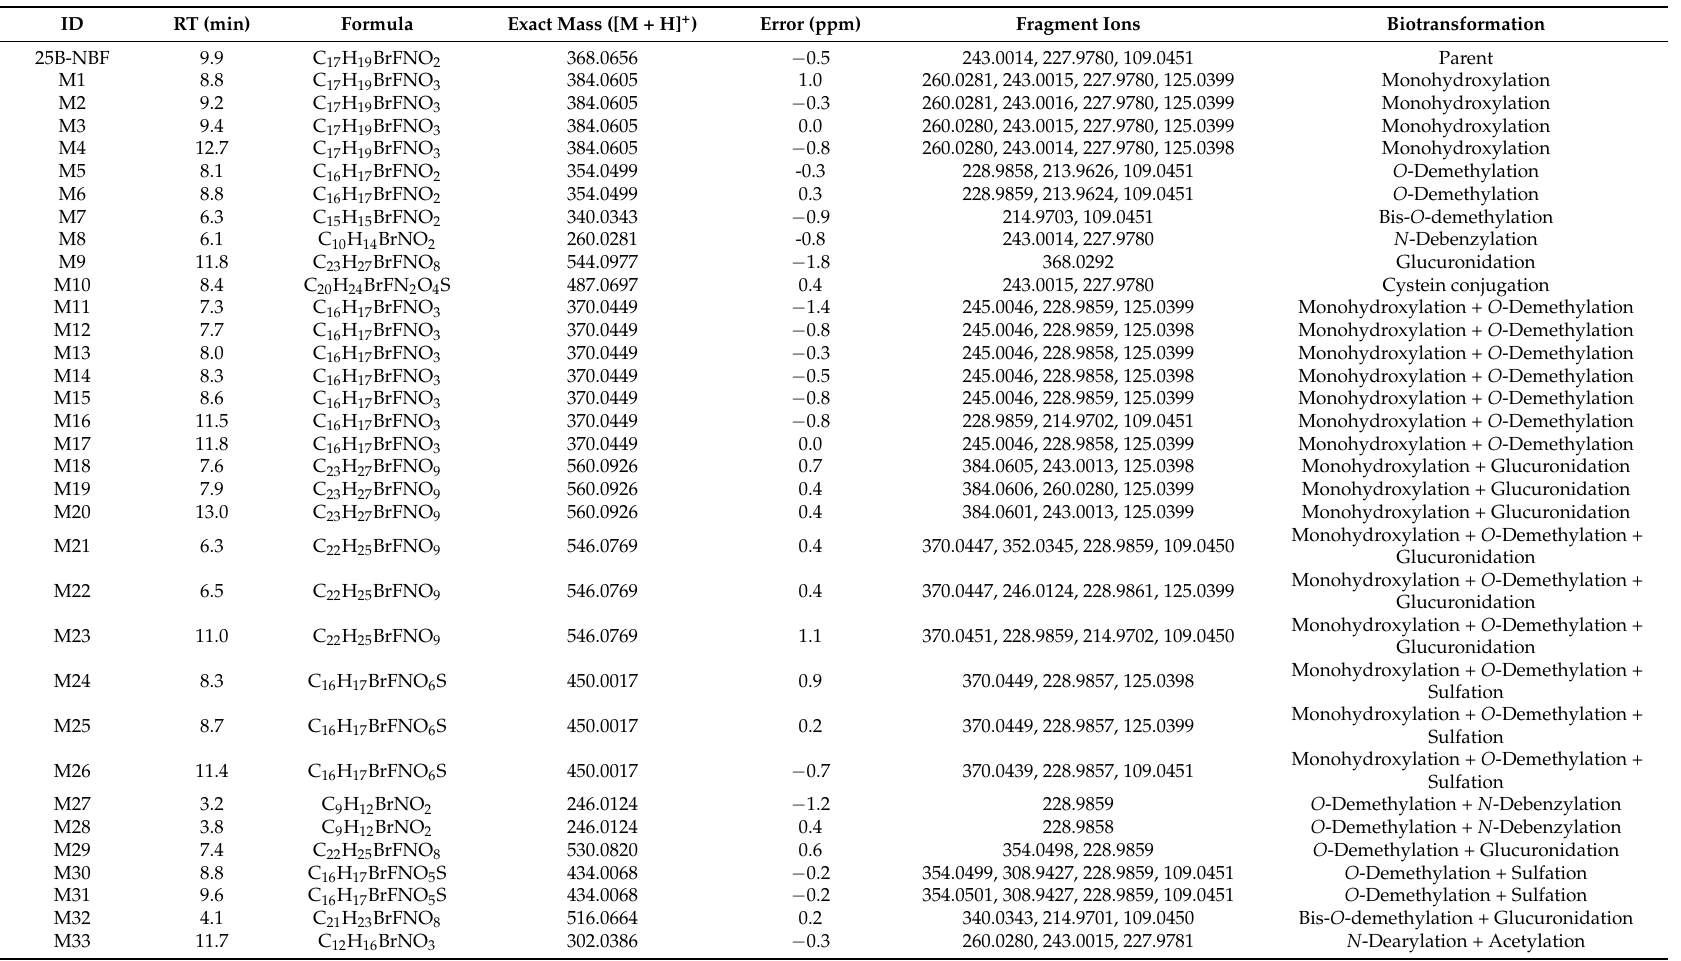
Retention times, molecular formulae, theoretical molecular ion masses, mass accuracies, fragment ions, and biotransformations of